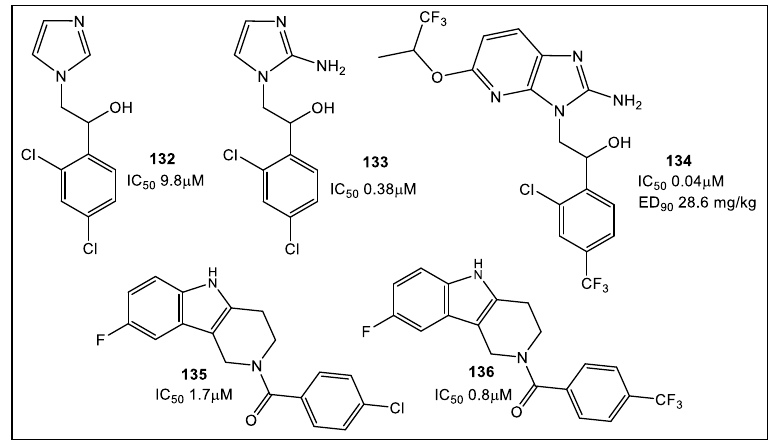
Figure 25. Best fragment hits against P. falciparum , 132 from a library of 1604 fragments and 133 and 134 from Astra Zeneca HTS screened 500,000 fragment corporate library. Tetrahydro- β -carboline compounds 135 and 136 from a 1604 fragment library against N. meningitidis .